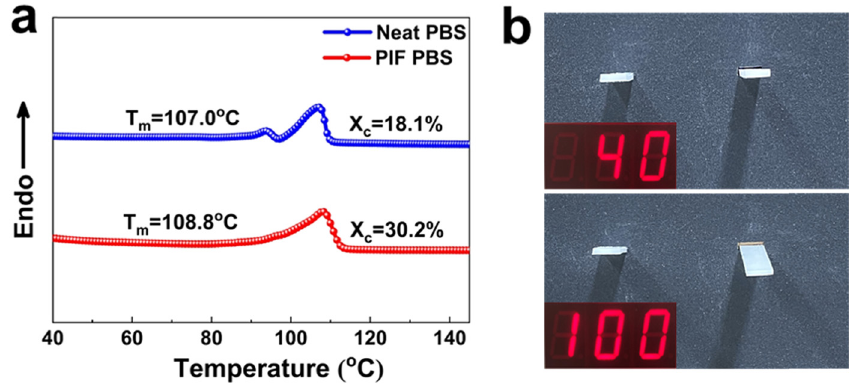
Figure 4: ( a ) Thermal properties of the samples: DSC heating curve of neat PBS and PIF PBS; ( b ) digital photo of neat PBS and PIF PBS treated in a hot air atmosphere at 40°C and 100°C for 2 h,